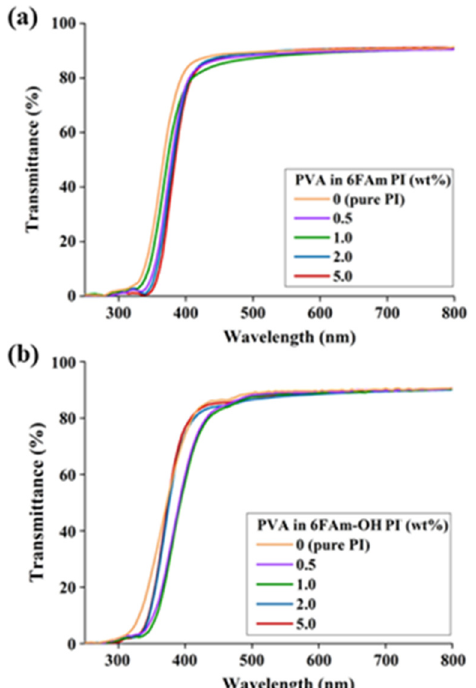
Figure 9. UV-vis transmittance of CPI membrane films containing ( a ) 6FAm and ( b ) 6FAm-OH with various PVA contents.